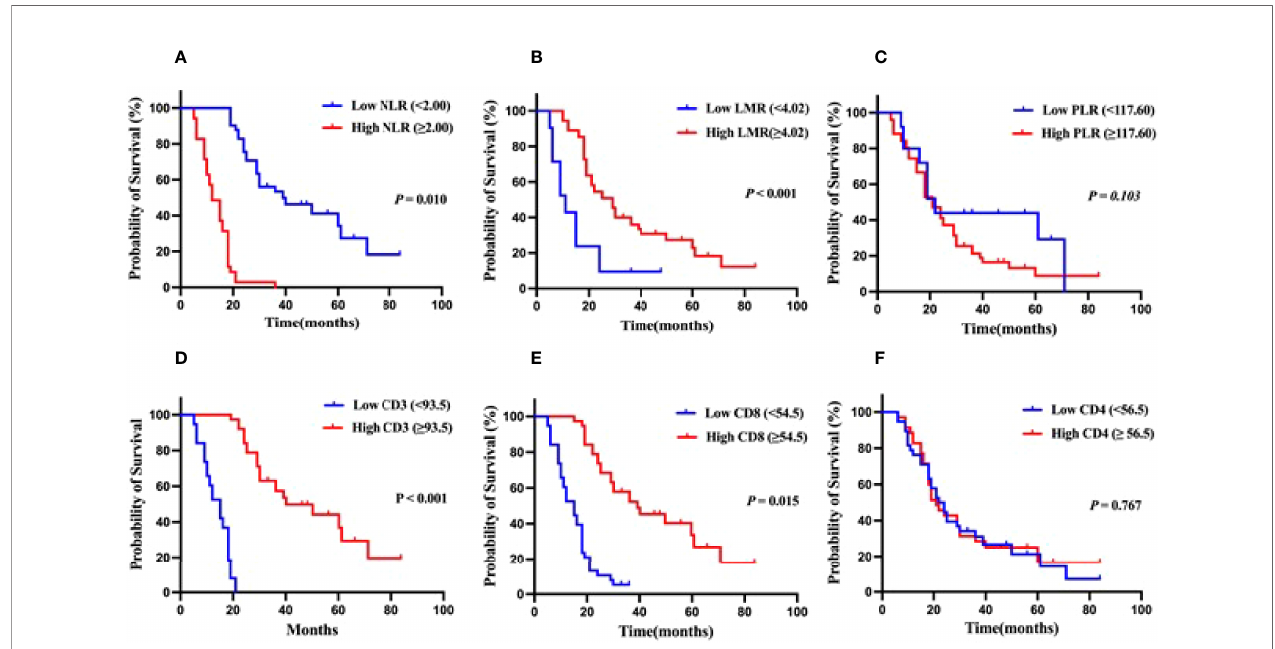
FIGURE 2 | Kaplan-Meier analysis for OS in patients with hilar cholangiocarcinoma. (A) OS for patients with different levels of NMR. (B) OS for patients with different levels of LMR. (C) OS for patients with different levels of PLR. (D) OS for patients with different levels of tumor-in fi ltrating CD3 + T cells in fi ltration. (E) OS for patients with different levels of tumor-in fi ltrating CD8 + T cells in fi ltration. (F) OS for patients with different levels of tumor-in fi ltrating CD4 + T cells in fi